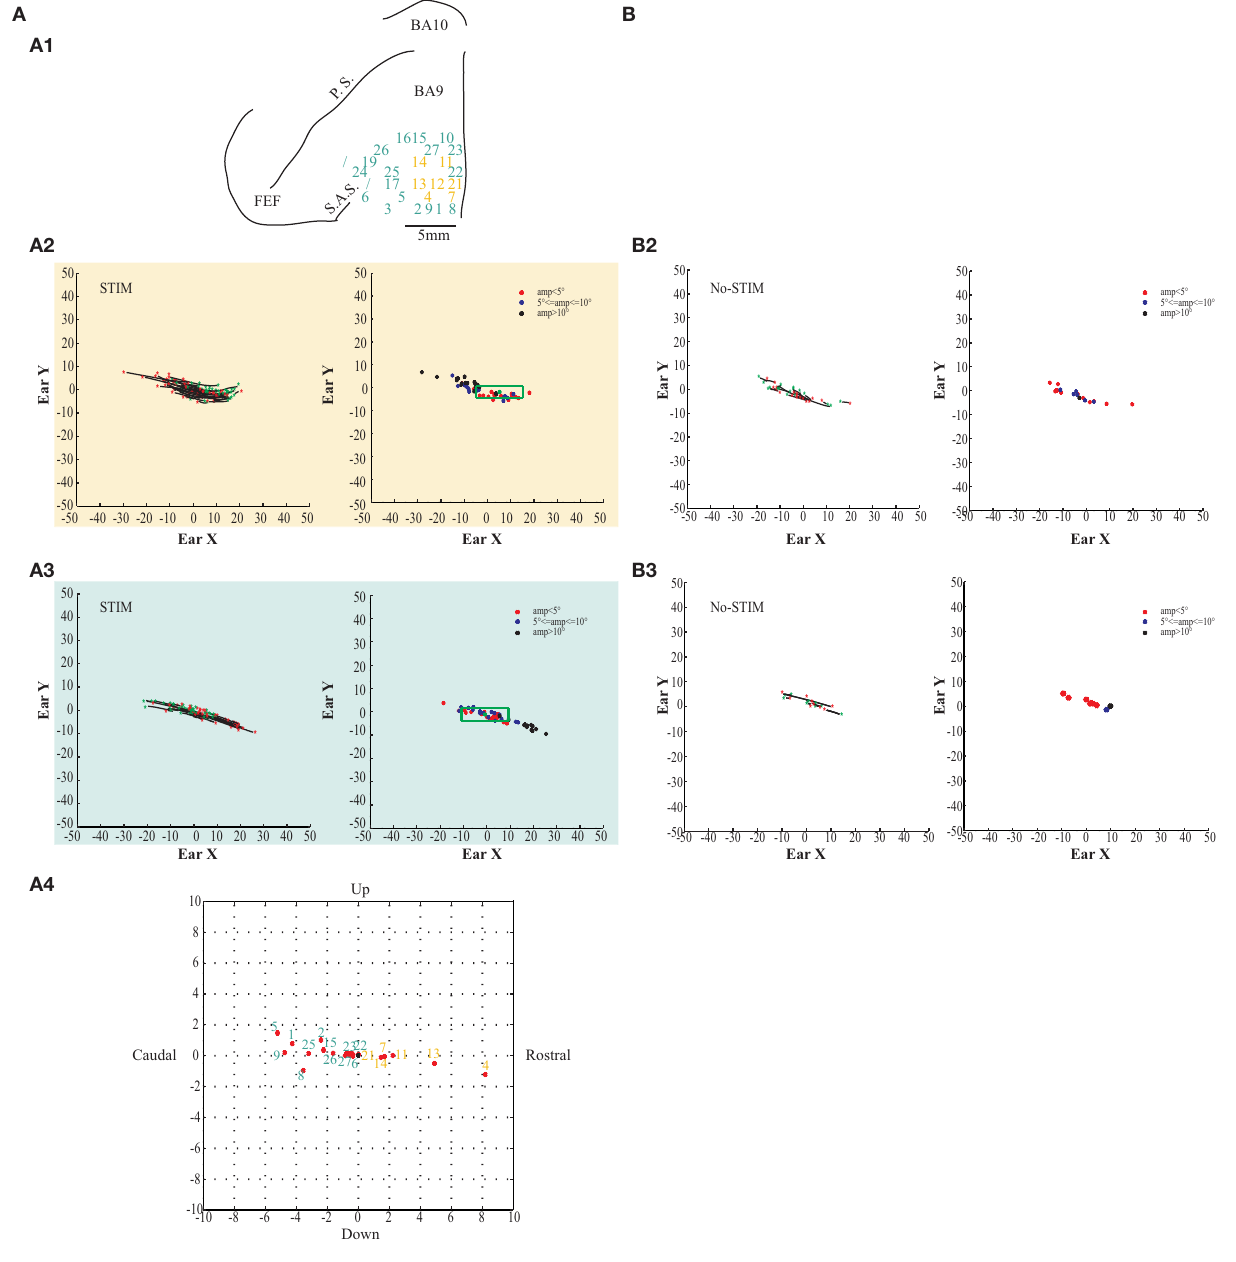
the amplitude of the evoked movement. Specifically, we plot- ted the starting positions of the evoked movements and their averaged end-points for each penetration. The starting positions were painted with one of three different colors: red, if the ampli- tude of the eye and ear movements was less than 5 ◦ ; blue, if the amplitude of the eye and ear movements was greater than or equal to 5 ◦ and less than or equal to 10 ◦ ; or black, if the amplitude of the eye and ear movements was greater than 10 ◦